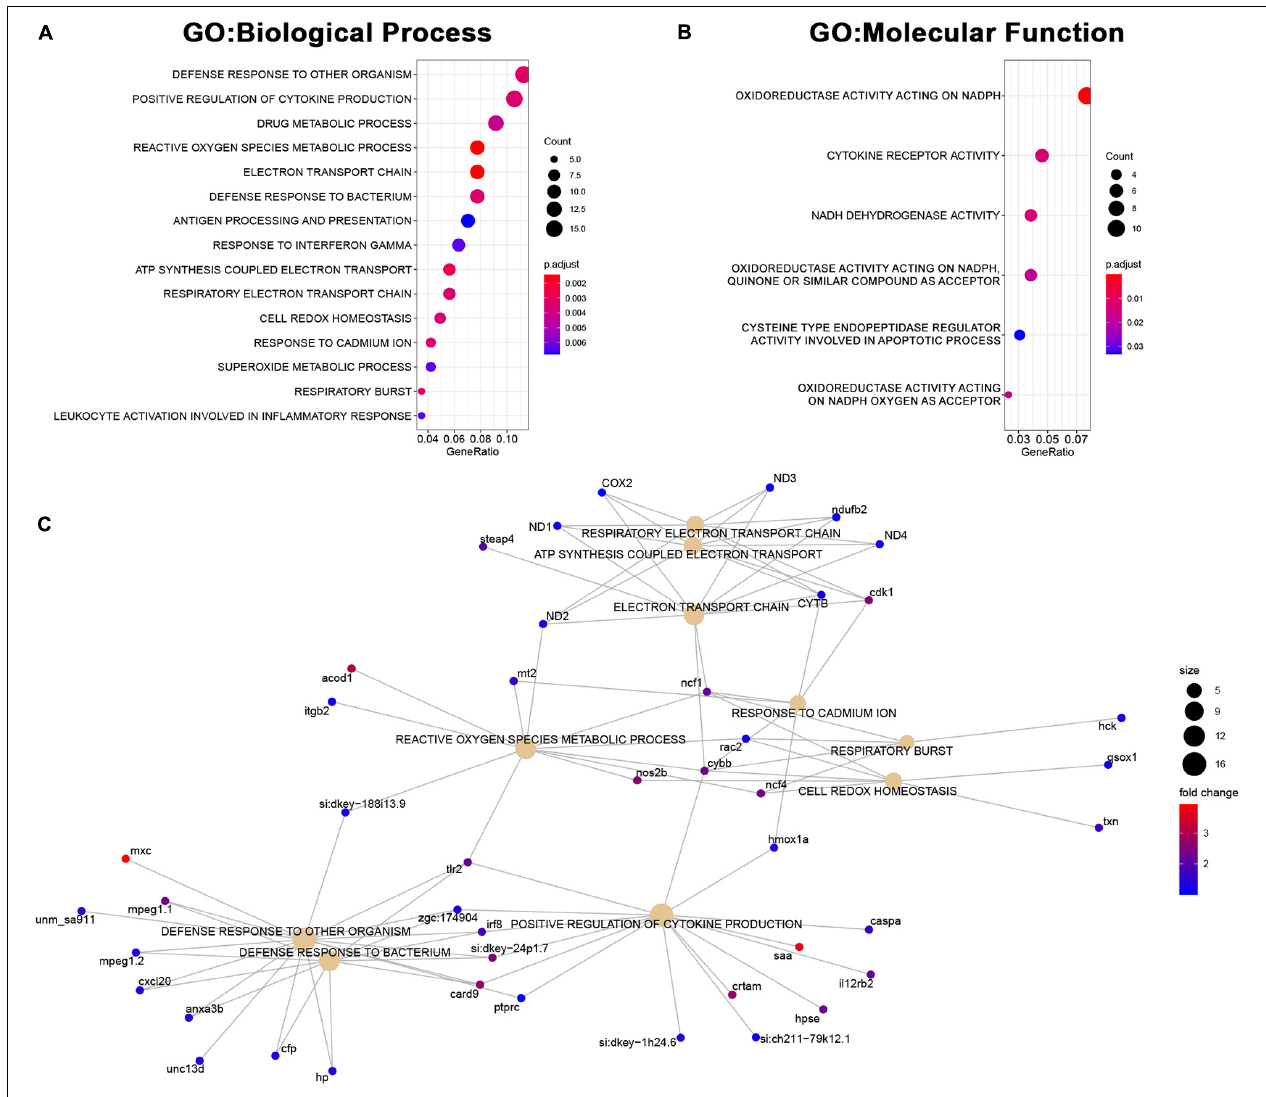
FIGURE 7 | Upregulated genes in MCU hearts reflect altered mitochondrial biology. (A, B) Dot plots of over-represented Biological Process (A) and Molecular Function (B) gene ontology terms in the set of genes that is significantly upregulated in MCU mutant hearts. The dot size indicates the number of genes associated with each term and the dot color indicates the significance of the enrichment (adjusted p -values). (C) Gene concept networks of the top 10 over-represented Biological Process gene ontology terms in the set of genes that is significantly upregulated in MCU mutants. The dot size indicates the number of genes associated with each term and dots representing genes are colored based on their fold-change